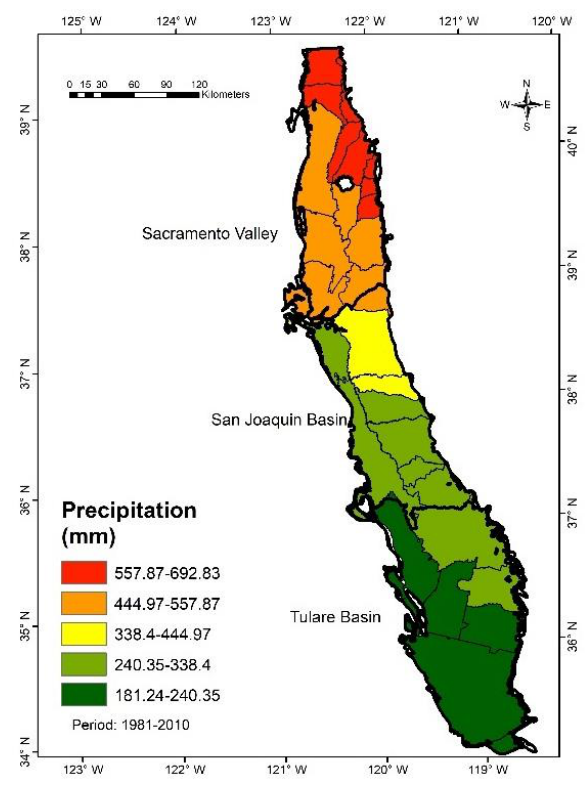
Figure 12. Precipitation distribution in Central Valley. (Data: 1981–2010). ISPRS Int. J. Geo-Inf. 2018 , 7 , x FOR PEER REVIEW